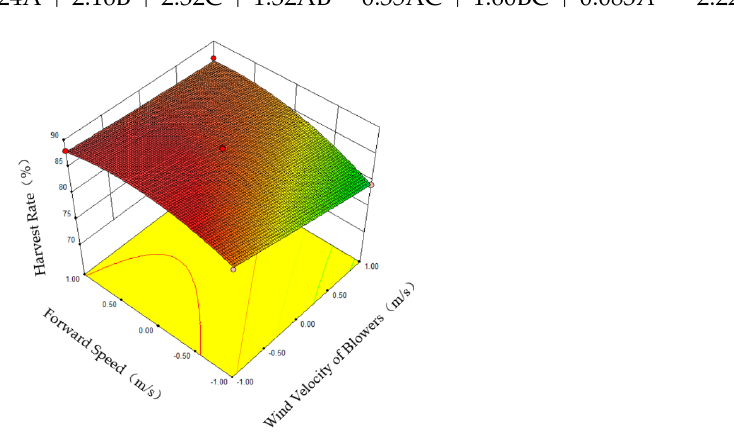
Figure 21. Interaction between wind velocity of blowers and drum rotational speed. 4.4. Optimal Parameters Taking the maximization of the collection rate as the objective, the optimization mod- ule in software Design-Expert 8.0 was used to solve the regression equation, thus deter- mining the optimal solution. The equation set of the objective and constraints is expressed as Equation (10). (cid:3422)MaxY(A ， B ， C 0.8 < 𝐴 < 1.2 1.0 < 𝐵 < 2.0 300 < 𝐶 < 400(cid:3426) (10) According to the optimized results, the optimal working parameters of the dandelion seed harvester were selected as follows: a forward speed of 0.8 m·s − 1 , a wind velocity of blowers of 1.63 m·s − 1 , and a rate of rotation of the drum of 418.7 rpm (rounded to 419 rpm). After adjusting the relevant parameters of the harvester, harvesting tests were conducted in which the collection rate reached 89.1% (as expected based on experimental evidence).